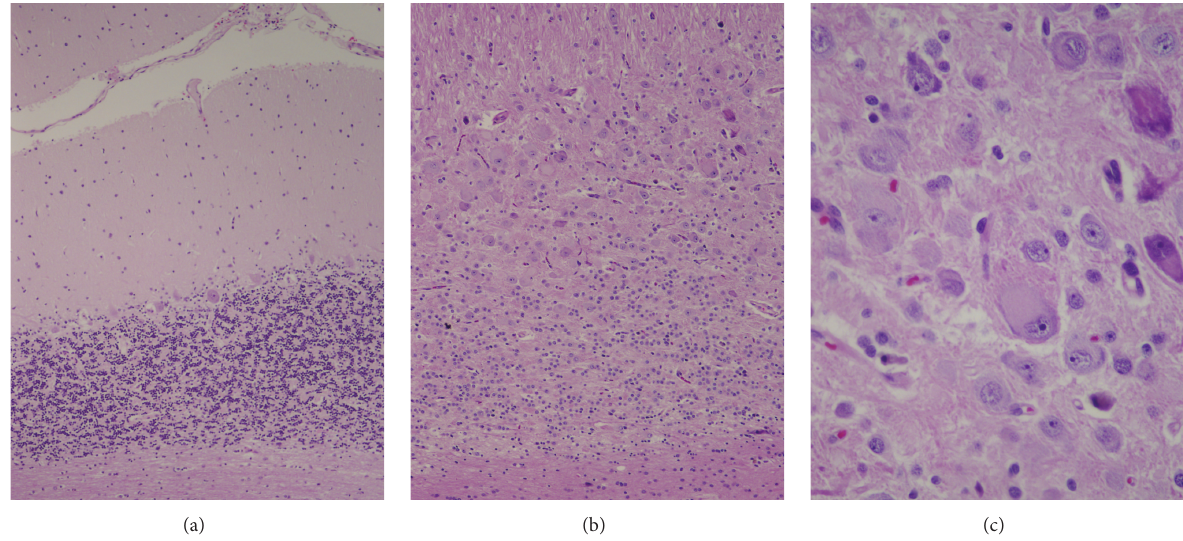
Figure 3: The surgical resection specimen includes a region of almost normal cerebellar parenchyma (a), with a normal granule cell layer that consists of fairly densely packed small neurons that are seen as blue nuclei separated by synaptic zones that are pink. The normal single layer of large Purkinje cells is located at the interface with the low cellularity molecular layer, here minimally more cellular than usual. Compare this with the images of the lesion (b and c). (b) The cerebellar granule cell layer in this region of the lesion is dysmorphic. Granule cells are scant and dispersed among ganglionic cells of varying sizes that expand this layer. (c) Detail of a region featured in upper right quadrant of panel (b) highlights the variable size of the abnormal ganglionic neurons characterized by relatively abundant cytoplasm and large nuclei with prominent nucleoli, some with abnormal irregularly shaped nuclei, that replace and expand the granule cell layer (hematoxylin and eosin paraffin sections; original magnifications: (a) 100x, (b) 200x, and (c)